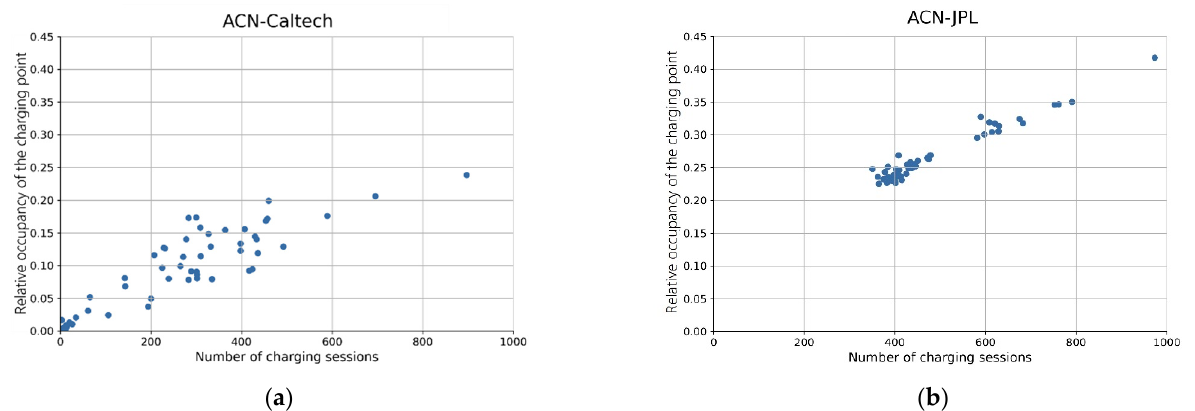
Figure 2. Relative occupancy for each charging point ( a ) at Caltech; ( b ) at JPL.